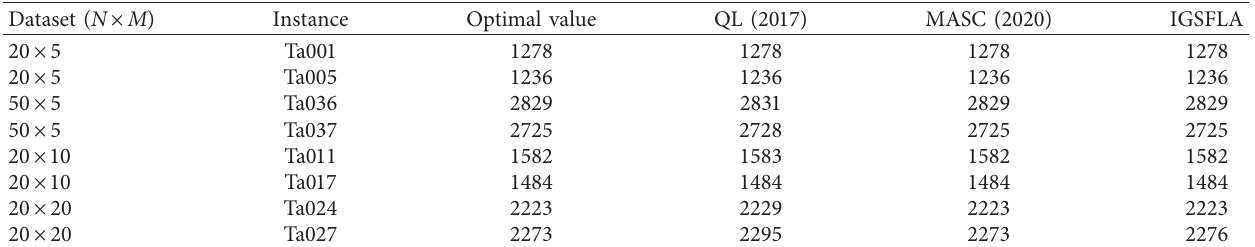
Table 6: Comparison between IGSFLA and some approaches on Taillard’s instances (unit: second). Dataset ( N × M